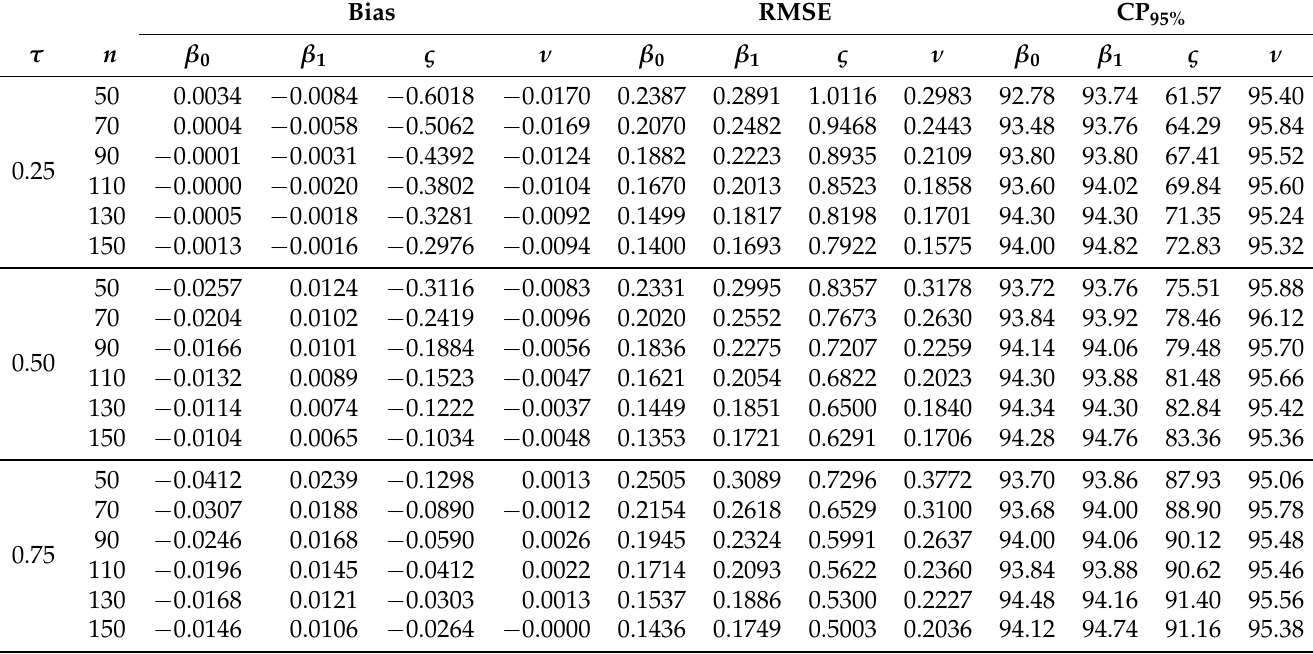
Table 10. Empirical RMSE, bias, and 95% CP (true values: β 0 = 0.50, β 1 = 0.50, ς = 2.00, and ν = 2.00) of the ML estimator for the indicated parameter with simulated